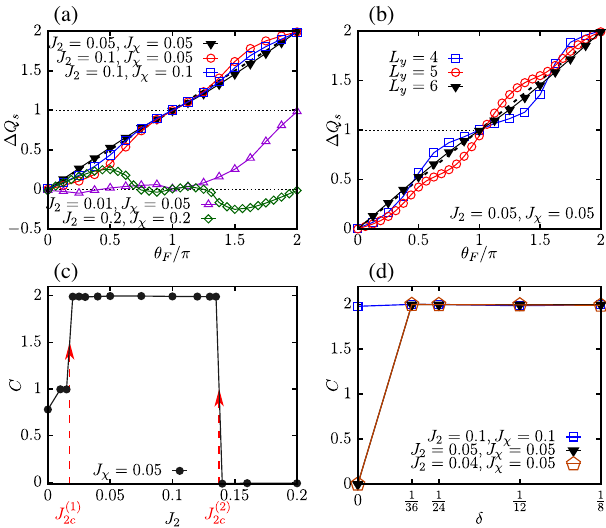
FIG. 2. The pumped spin by inserting flux and spin Chern number. (a) The pumped spin Δ Q s with adiabatically inserted flux θ F is shown for different SC phases on the L y ¼ 6 cylinder. For the three parameter points in the SC2 phase, the measured spin pumping after inserting one flux quantum Δ Q s j 2 π 0 ¼ 1 . 993 , 1.983, and 1.990, respectively, indicating that the error bar is around 1% from the exactly quantized value Δ Q s j 2 π 0 ¼ 2 for different systems. (b) Δ Q s versus θ F for J 2 ¼ J χ ¼ 0 . 05 inside SC2 phase on L y ¼ 4 , 5, 6 cylinders. (c) The evolution of Chern number C with varying J 2 at J χ ¼ 0 . 05 on L y ¼ 6 . C ¼ Δ Q s j 2 π 0 is obtained after inserting one flux quantum θ F ¼ 0 → 2 π . SC1- SC2 and SC2-SC0 phase transitions take place at J 2 ¼ J ð J ð 2 Þ 2 c , respectively, where the Chern number jumps. The doping level is δ ¼ 1 = 12 for (a) – (c). (d) C versus δ for parameter points with different undoped parent states (e.g., DAFM or DCSL) on L y ¼ 6